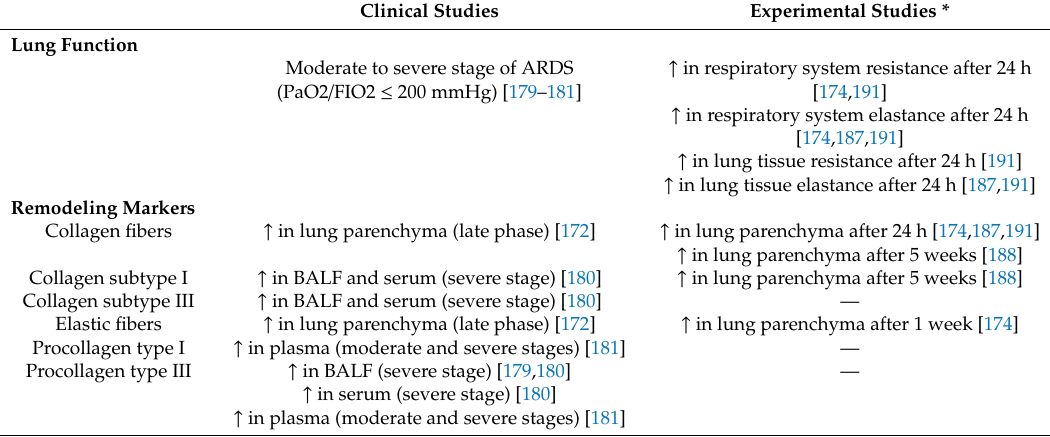
Table 4. Lung function changes and markers of ECM remodeling in acute respiratory distress syndrome (ARDS). Clinical Studies Experimental Studies * Lung